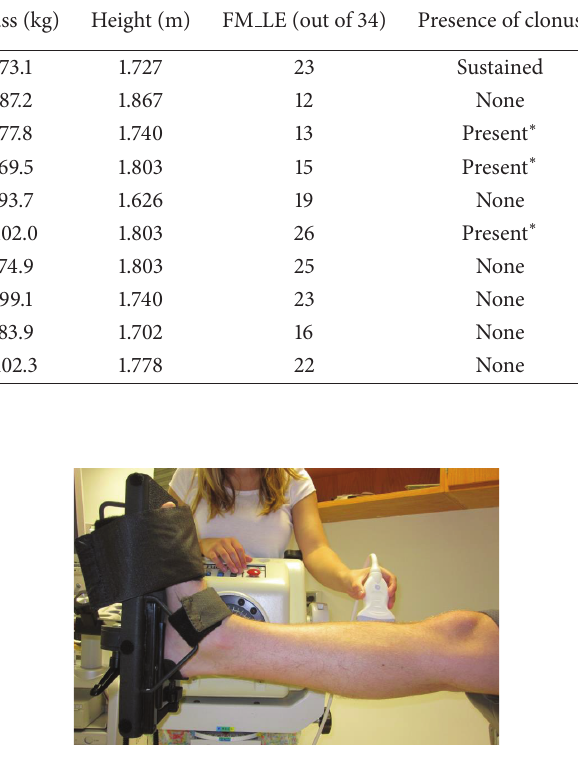
Figure 1: Subject in isometric dynamometer with ankle secured in neutral position. Ultrasound images were taken at the midbelly of the tibialis anterior. Care was taken to keep the probe perpendicular to the skin. Enough pressure was applied to maintain proper contact between the probe and skin without significantly deforming the